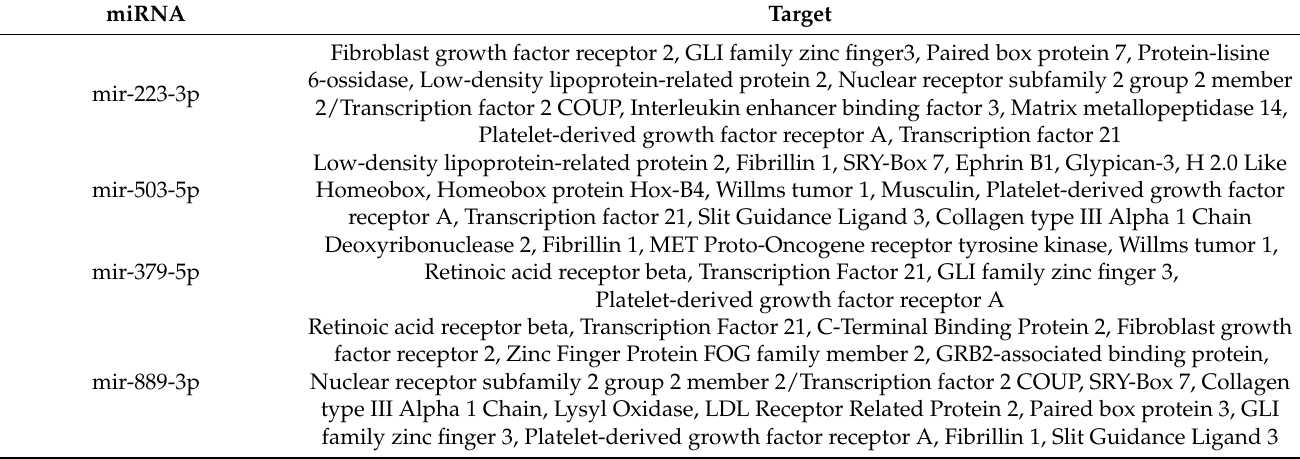
Table 5. List of the miRNA predicted target genes.